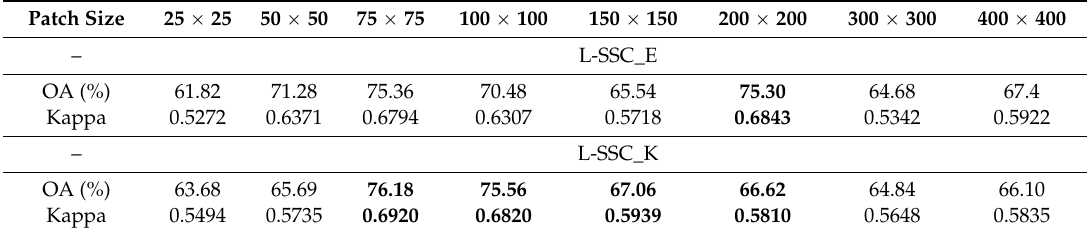
Table 8. The clustering accuracy of different patch sizes for the Fancun image.